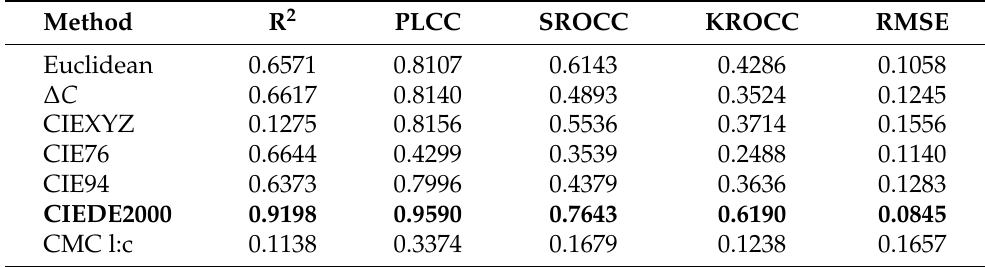
Table 1. Performance of different methods used for nitrogen calculation. The best results are marked in